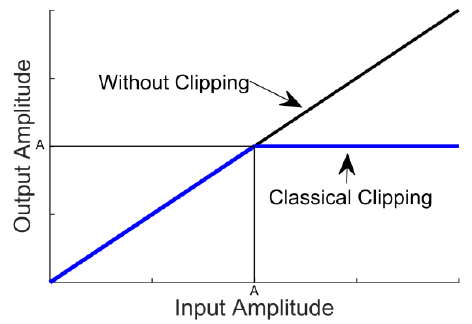
Figure 2. Classical Clipping Function.